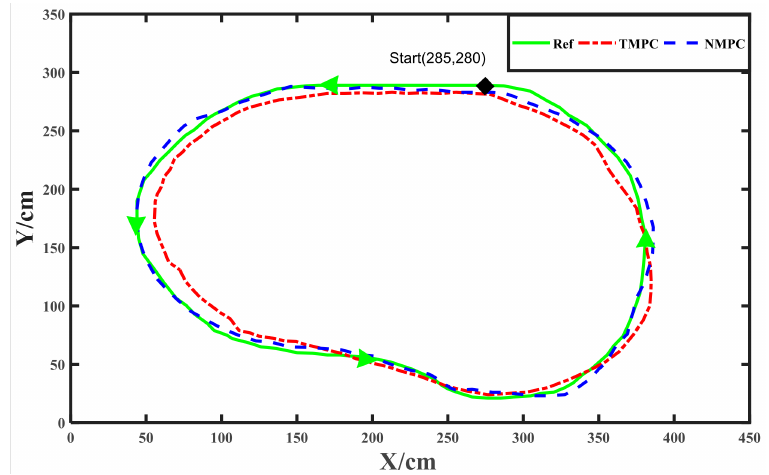
Figure 14. The tracking response curves of the two MPC controllers under the ITR.